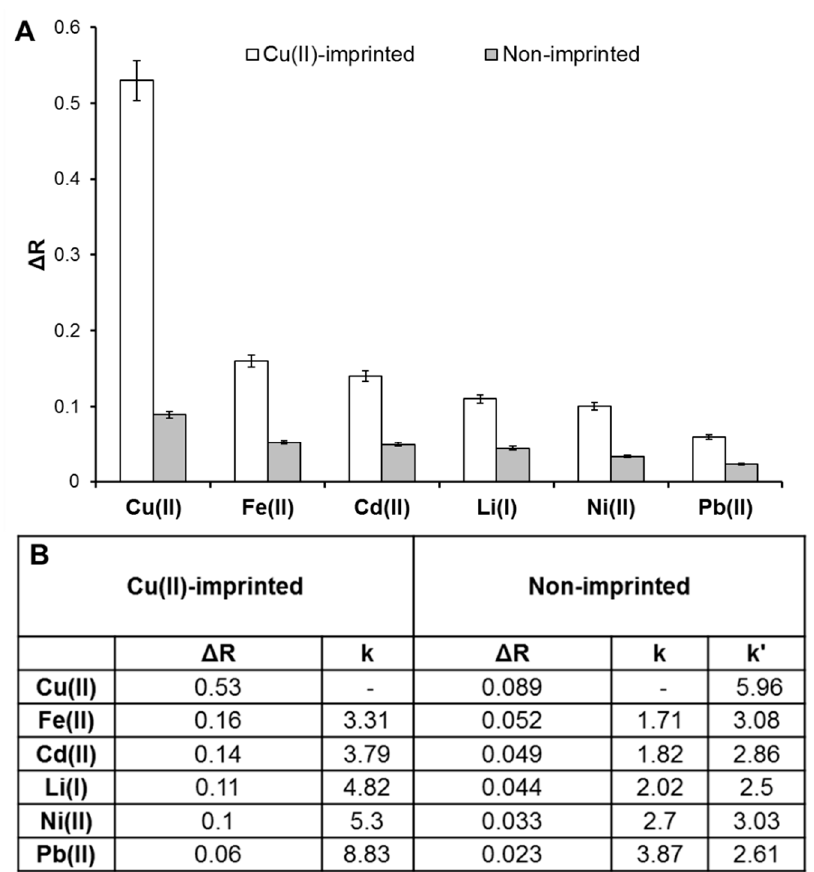
Figure 6. Selectivity performances ( A ) and selectivity coefficients ( B ) of Cu(II)-imprinted and non- imprinted plasmonic sensors.